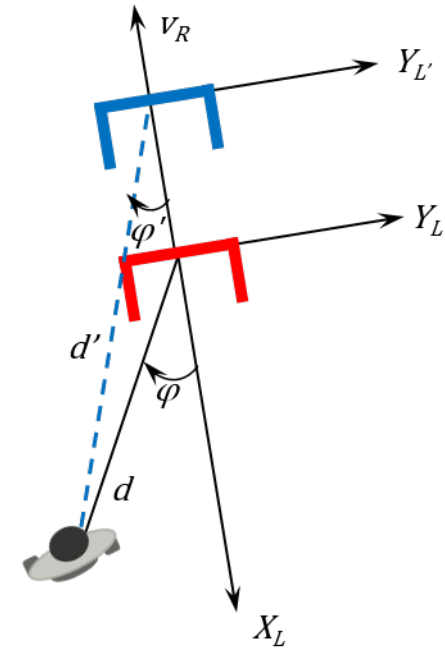
Figure 11. Projection of the previous position in the current